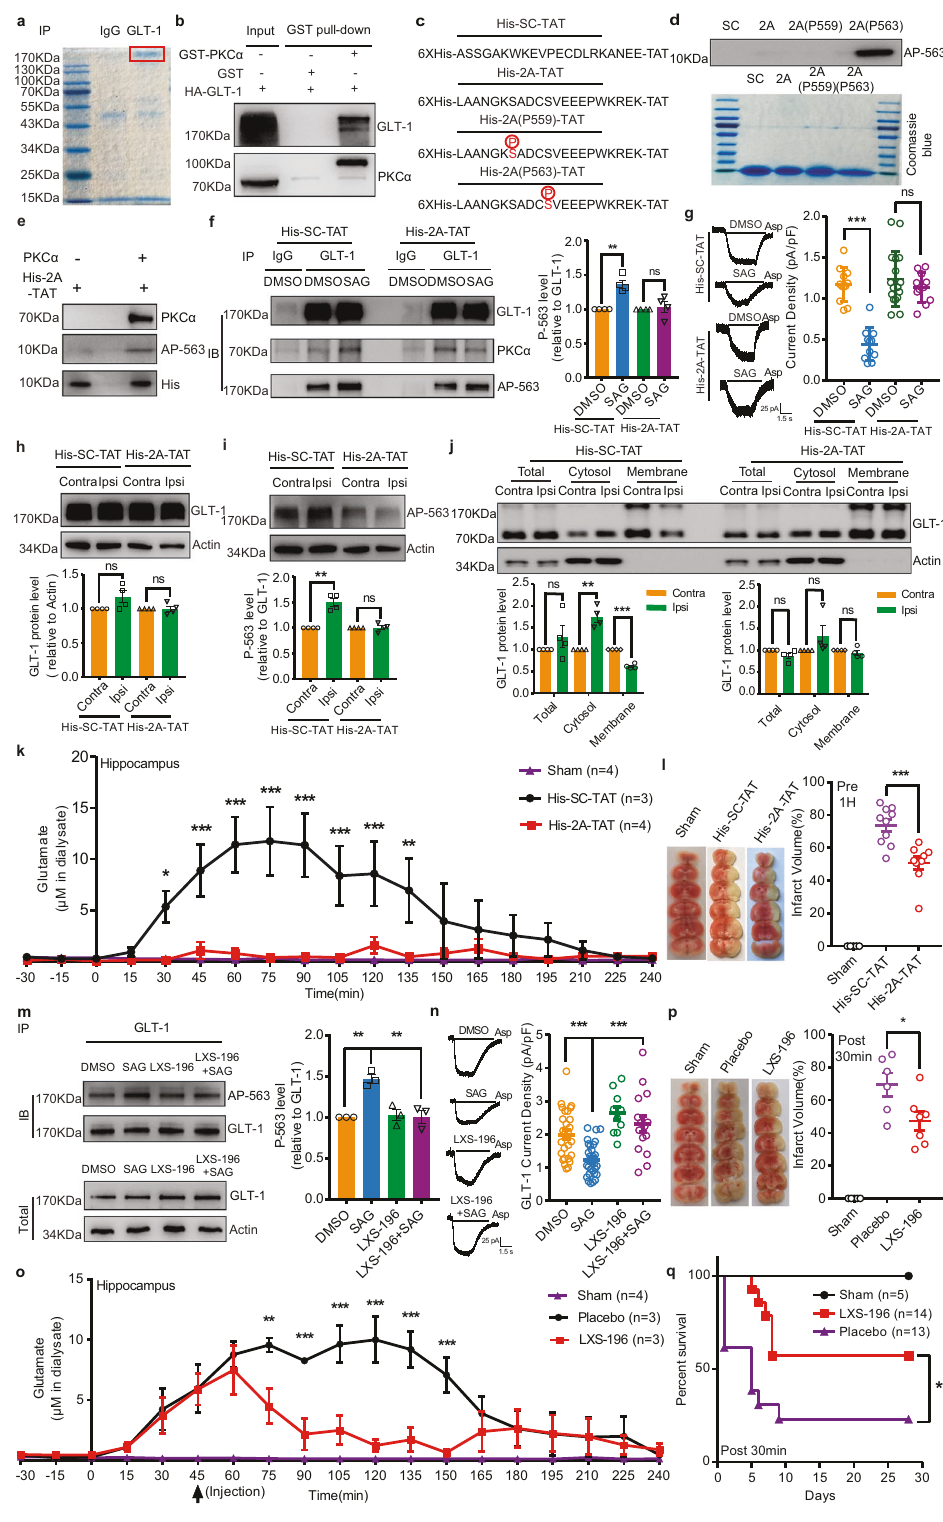
To further explore the translational possibility of LXS-196 for treating cerebral ischemia, we intravenously injected LXS-196